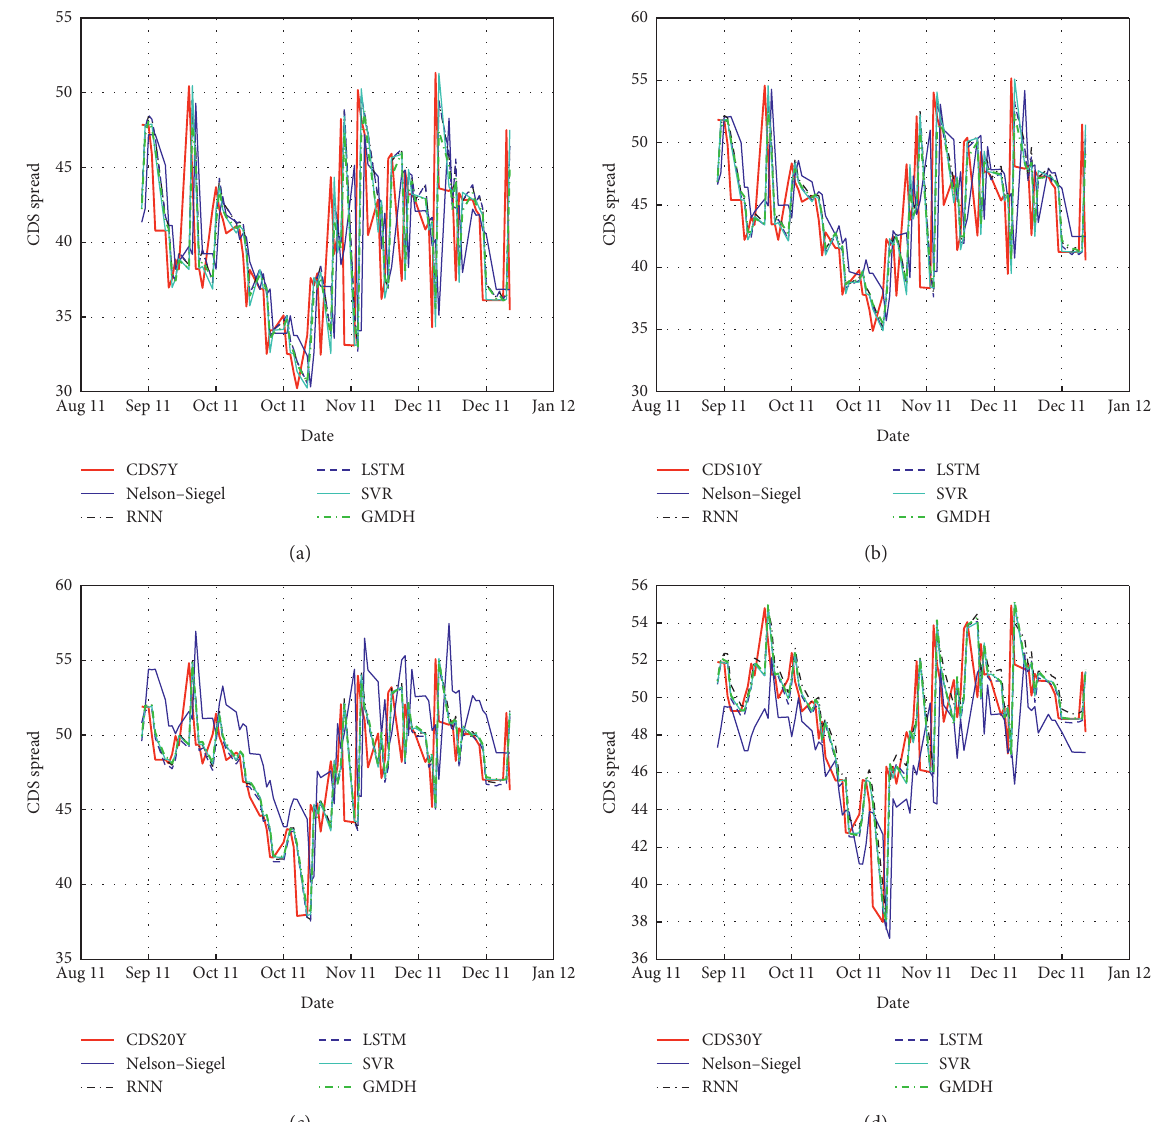
Figure 9: Predictions of each model and target CDS term structure from seven years to 30 years maturity for test dataset 2 with the subperiod 1 training set (case